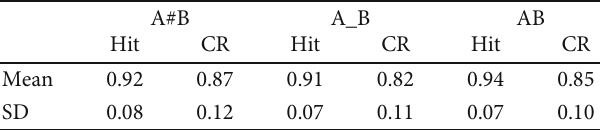
Table 2: Mean judgment accuracy (%) ( N = 12